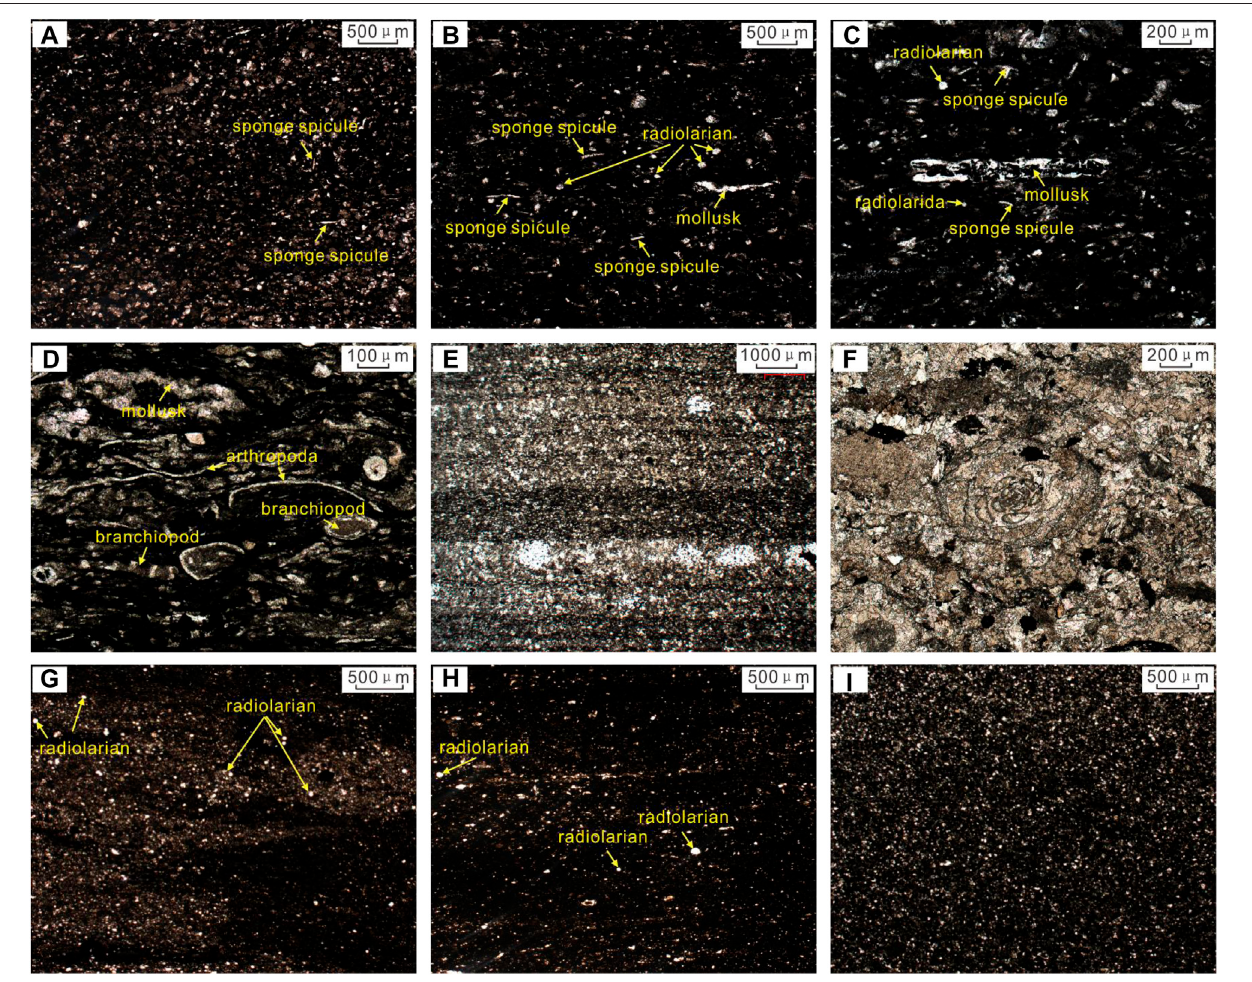
FIGURE 4 | Microscopic characteristics for Linghao Formation from the studied well in the central Nanpanjiang basin. (A) Sponge spicule in marine shale, upper Ling 1 Member, 3,772.88 m, plane-polarized light. (B) Marine bioclasts including sponge spicule, radiolarian, and mollusk, upper Ling 1 Member, 3773 m, plane- polarized light. (C) marine shale containing abundant marine bioclasts including sponge spicule, radiolarian, and mollusk, upper Ling 1 Member, 3,772.97 m, plane- polarized light. (D) Mudstone containing abundant marine bioclasts including branchiopod, arthropoda and mollusk, Ling 2 Member, 3,558.63 m, plane-polarized light. (E) Silty mudstone, Ling 2 Member, 3,558.68 m, plane-polarized light. (F) Bioclastic limestone rich in shallow benthic bioclastics, Ling 2 Member, 3,738.13 m, plane-polarized light. (G) Marine shale rich in radiolarian, lower Ling 3 Member, 3,414.91 m, plane-polarized light. (H) Marine shale rich in radiolarian, lower Ling 3 Member, 3,414.62 m, and plane-polarized light. (I) marine shale rich in detrital quartz, lower Ling 3 Member, 3,412.12 m, plane-polarized light.